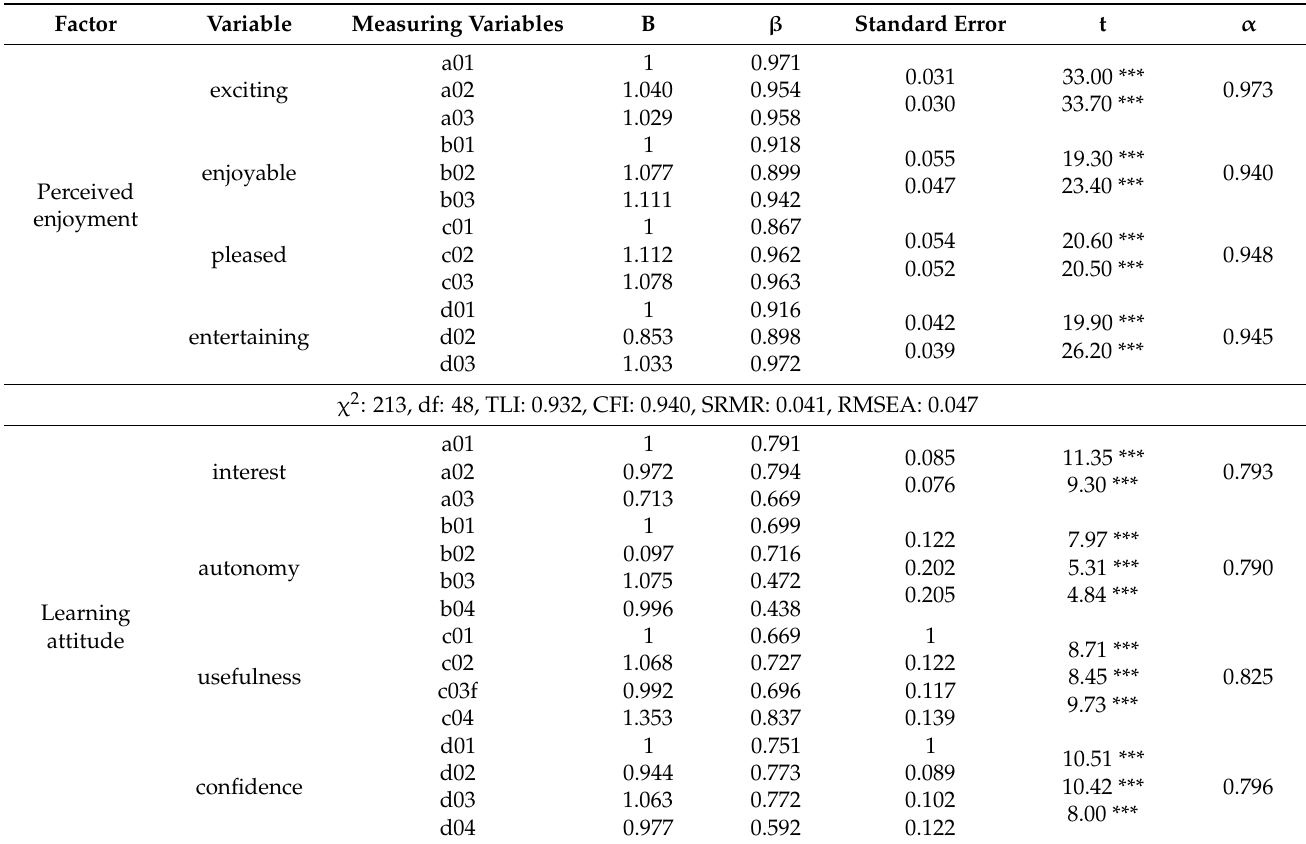
Table 2. Table 2. Confirmatory factor analysis and reliability of latent